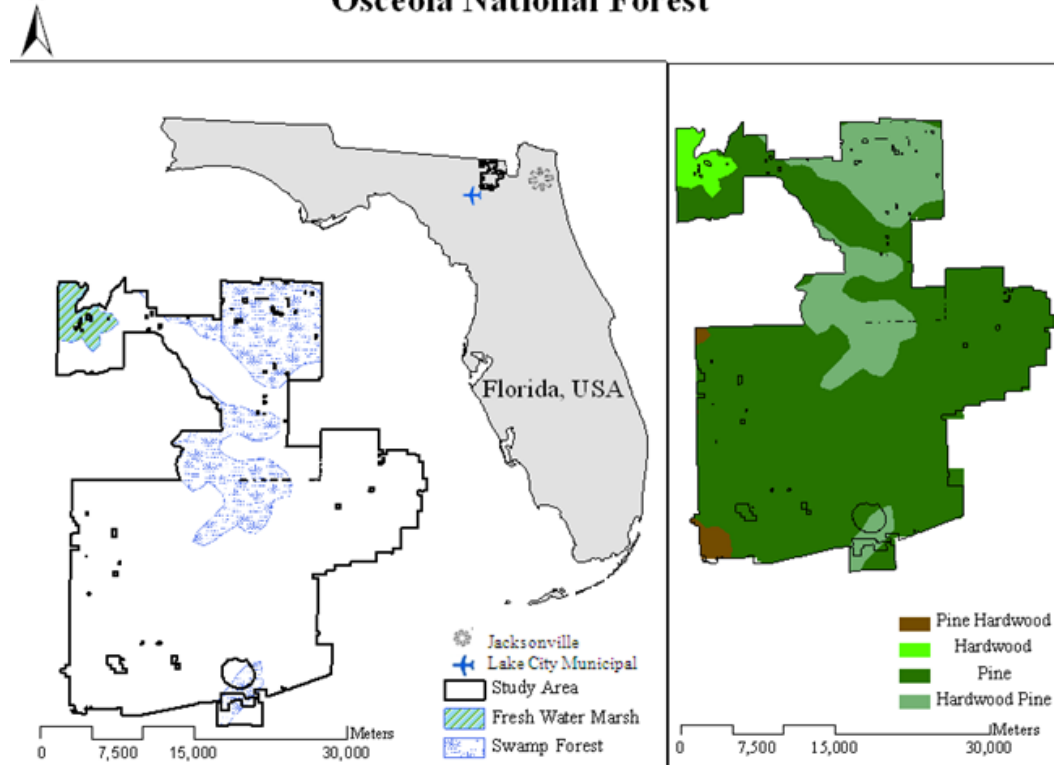
Figure 1. Location of the Osceola National Forest and dominant overstory